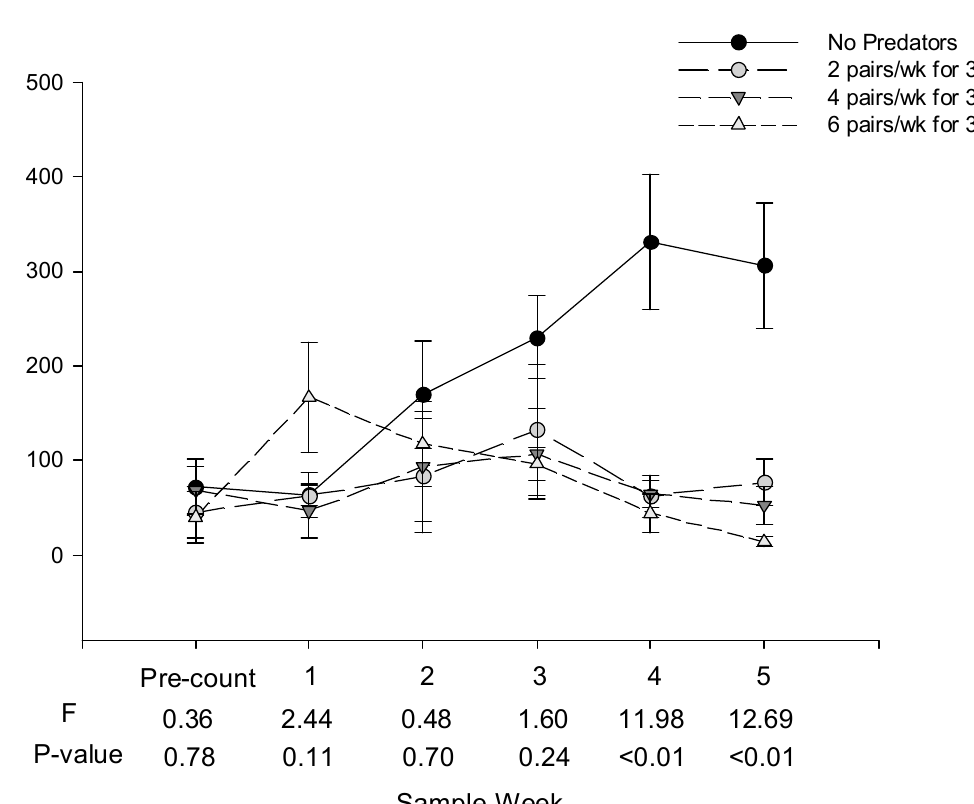
Figure 2. Mean ( ± SE) number of B. tabaci nymphs per tomato leaf on tomato plants receiving low, medium and high release rates of D. hesperus. D. hesperus were released on 22 Nov, when the pre-count was taken, and 29 Nov and 6 Dec, 2016, the same days that readings 1 and 2 were collected; when sample dates coincide with release, cages were sampled first.